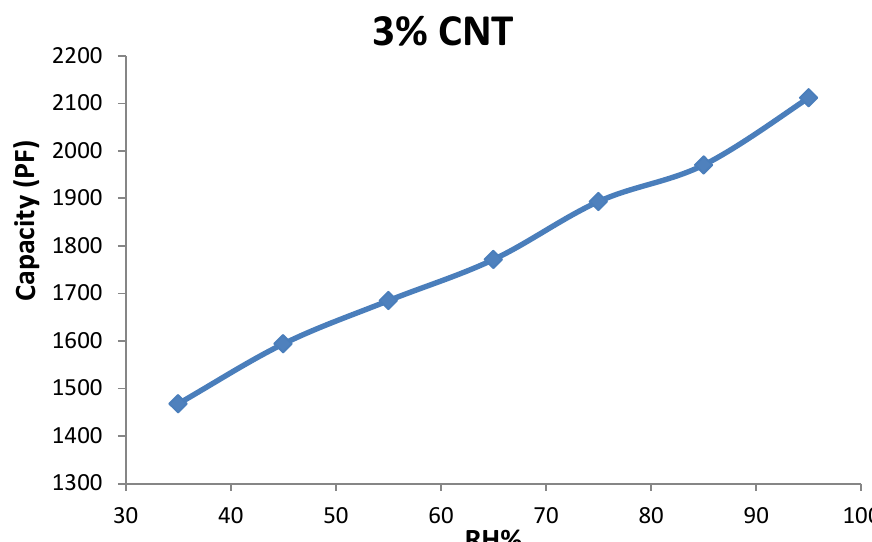
Fig.6: Humidity capacitance relationship for humidity sensors with 3% MWCNT.